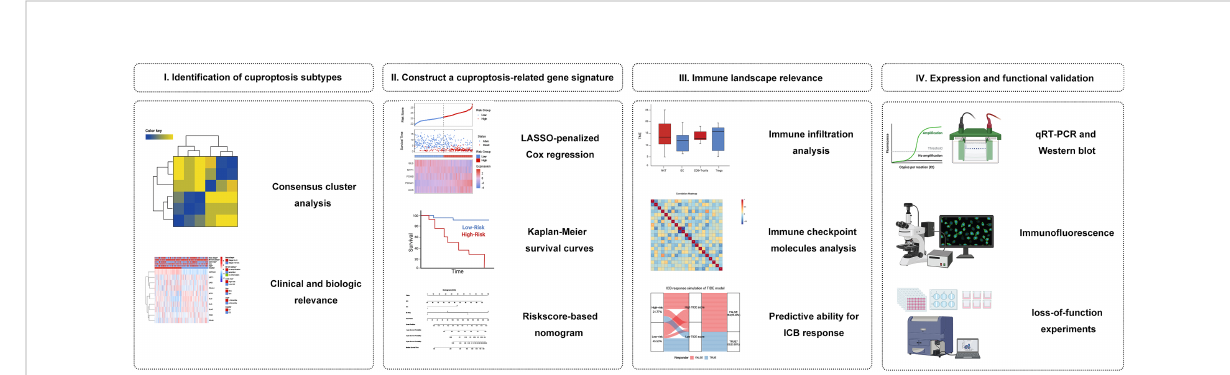
FIGURE 1 Graphical abstract. (I) Identi fi cation and comprehensive analysis of cuproptosis subtypes in NB. (II) Construction and validation of the cuproptosis signature in NB. (III) Association with immune in fi ltration, immune checkpoint molecules, and its predictive ability for the response to immunotherapy. (IV) Expression Validation and Functional